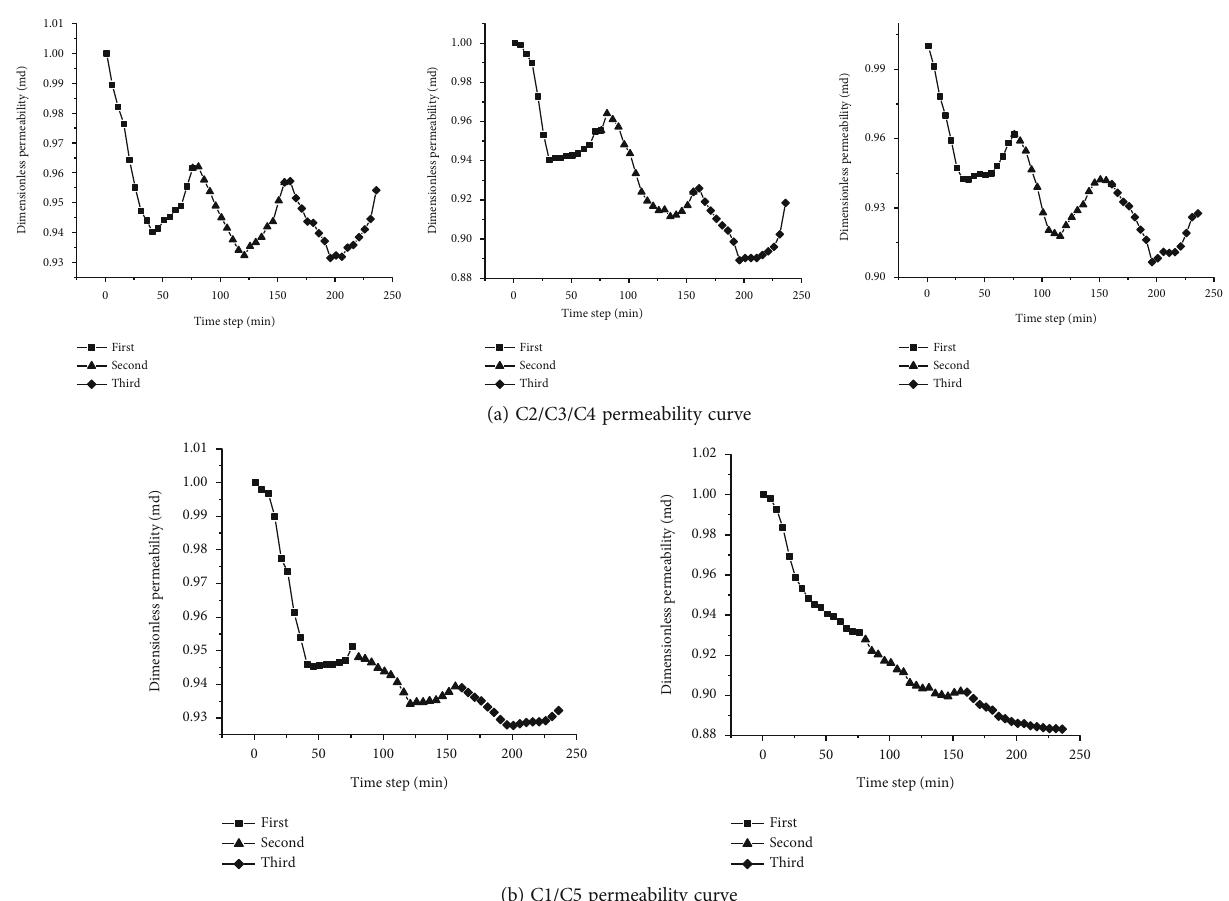
Figure 4: Permeability curve for samples C1/C2/C3/C4/C5.